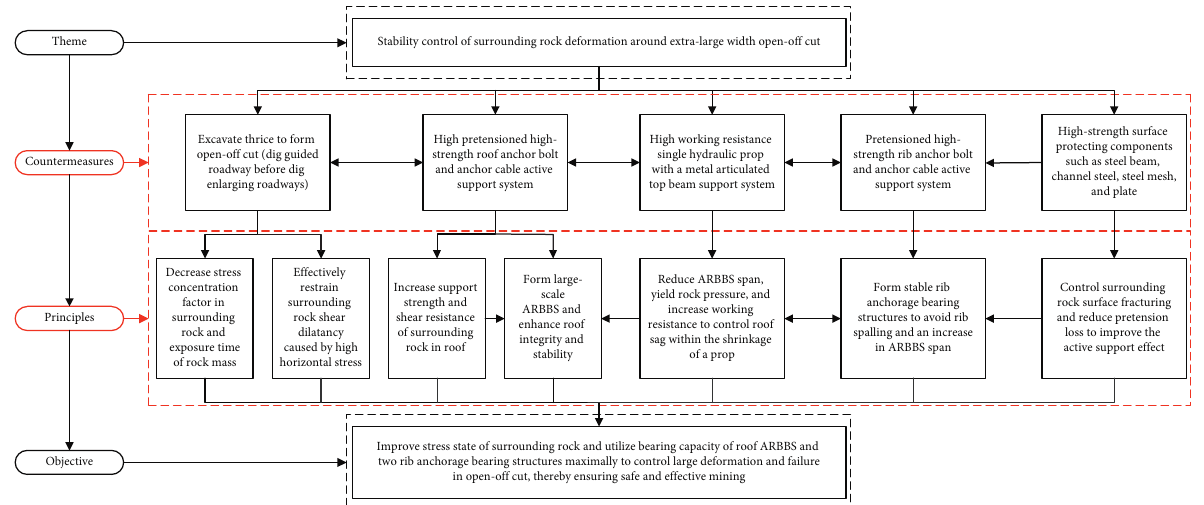
Figure 15: Logic relation diagram of surrounding rock deformation control around extra-large width open-off cut.